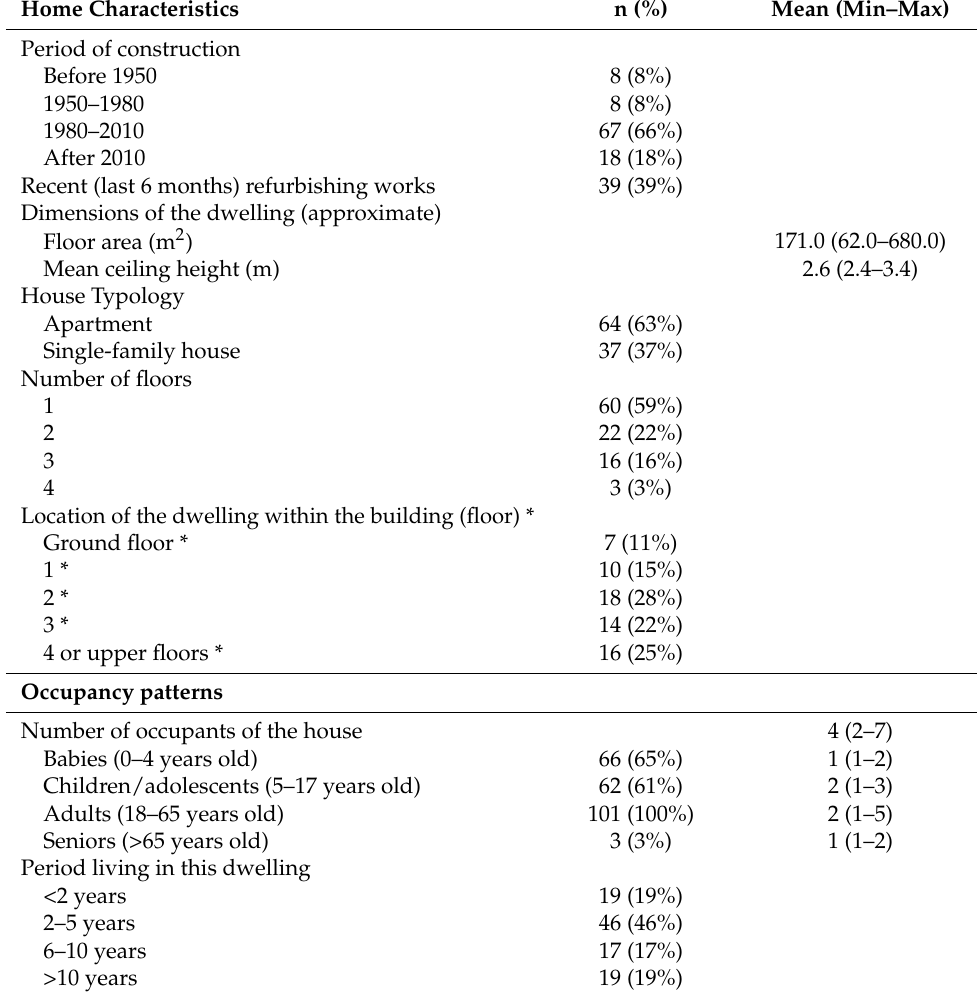
Table 1. Summary of the results collected through a checklist on the characteristics of the participants’ homes. Home